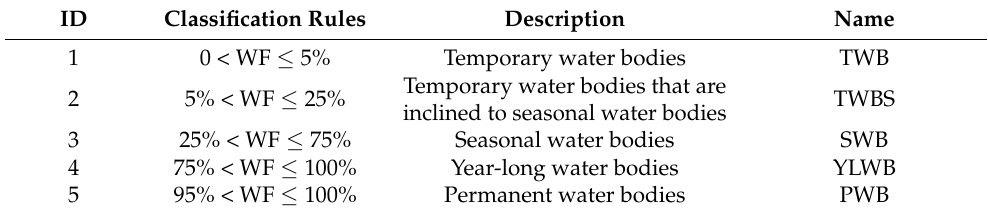
Table 2. Classification rules for water types based on the water frequency.